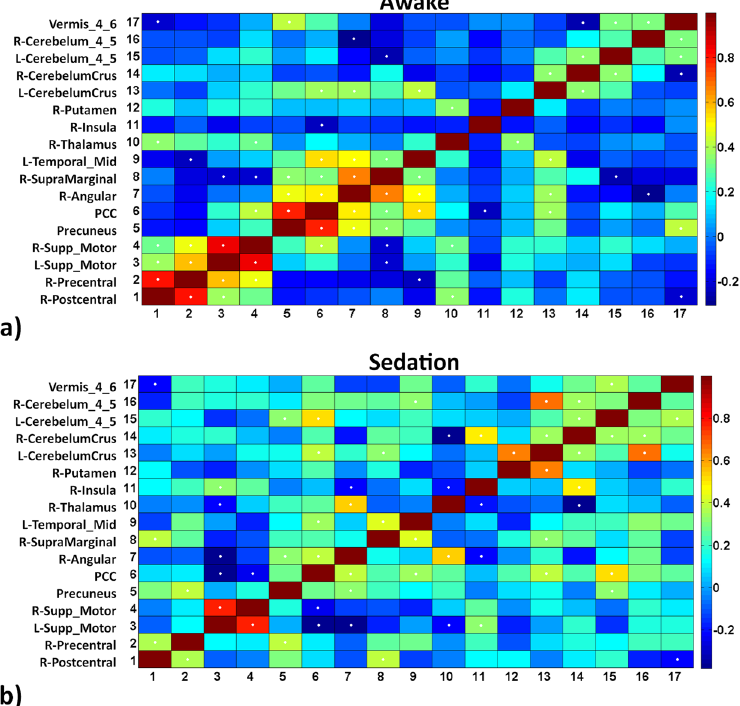
Figure 5. Correlation of the connectivity of the 17 areas which revealed significant changes during sedation. Baseline state ( a ) reveals significant (white stars) correlation of connection between right pre-central, post- central, and bilateral supplementary motor cortex. During sedation ( b ) only significant connection in the peri-rolandic region was between right pre-and post-central gyrus. Similar changes are also appreciable in the subcomponents of DMN (precuneus, posterior cingulate cortex (PCC), angular gyrus, and left mid-temporal region). Significantly increased connectivity of the bilateral cerebellum, vermis, and of thalamus and PCC during sedation ( b ) probably indicates re-organisation of these